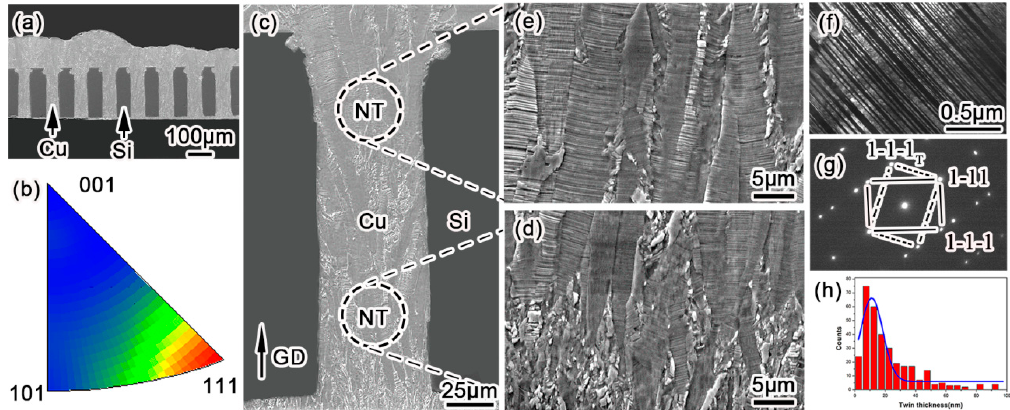
Figure 2. The microstructure of nanotwinned Cu-filled through silicon via (TSV) electroplated with 30 mA/cm 2 and 300 rpm. ( a ) Void-free plating of Cu in TSV array before surface CMP (Chemical Mechanical Polishing); ( b ) EBSD grain orientation mapping of <111> Cu along the growth direction; ( c ) columnar grain morphology with lamellar striation in one via; ( d ) enlarged bottom and ( e ) top microstructure of TSV with a high density of nanotwins; ( f ) Dark-field TEM image of nanotwinned structure, and ( g ) the corresponding [110] Cu diffraction pattern, where spots from the matrix and the twin lamella are denoted by solid and dashed lines, respectively; ( h ) Histogram of twin thicknesses derived from edge-on TEM observations.